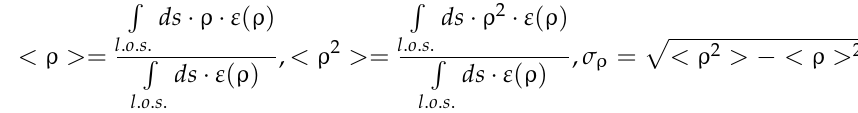
halo effect and with halo effect.